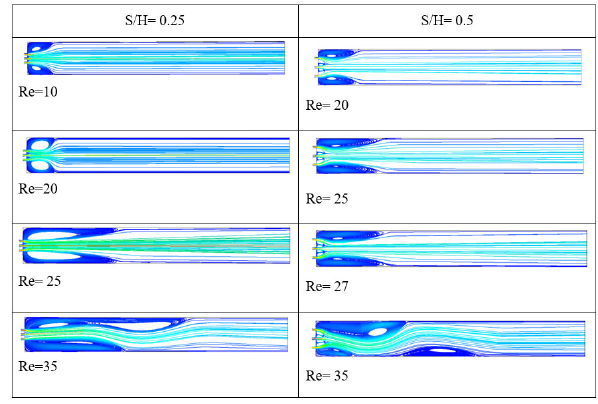
Figure 6: Streamlines of characteristic flows for S/H = 0.75, 0.9 in three jets